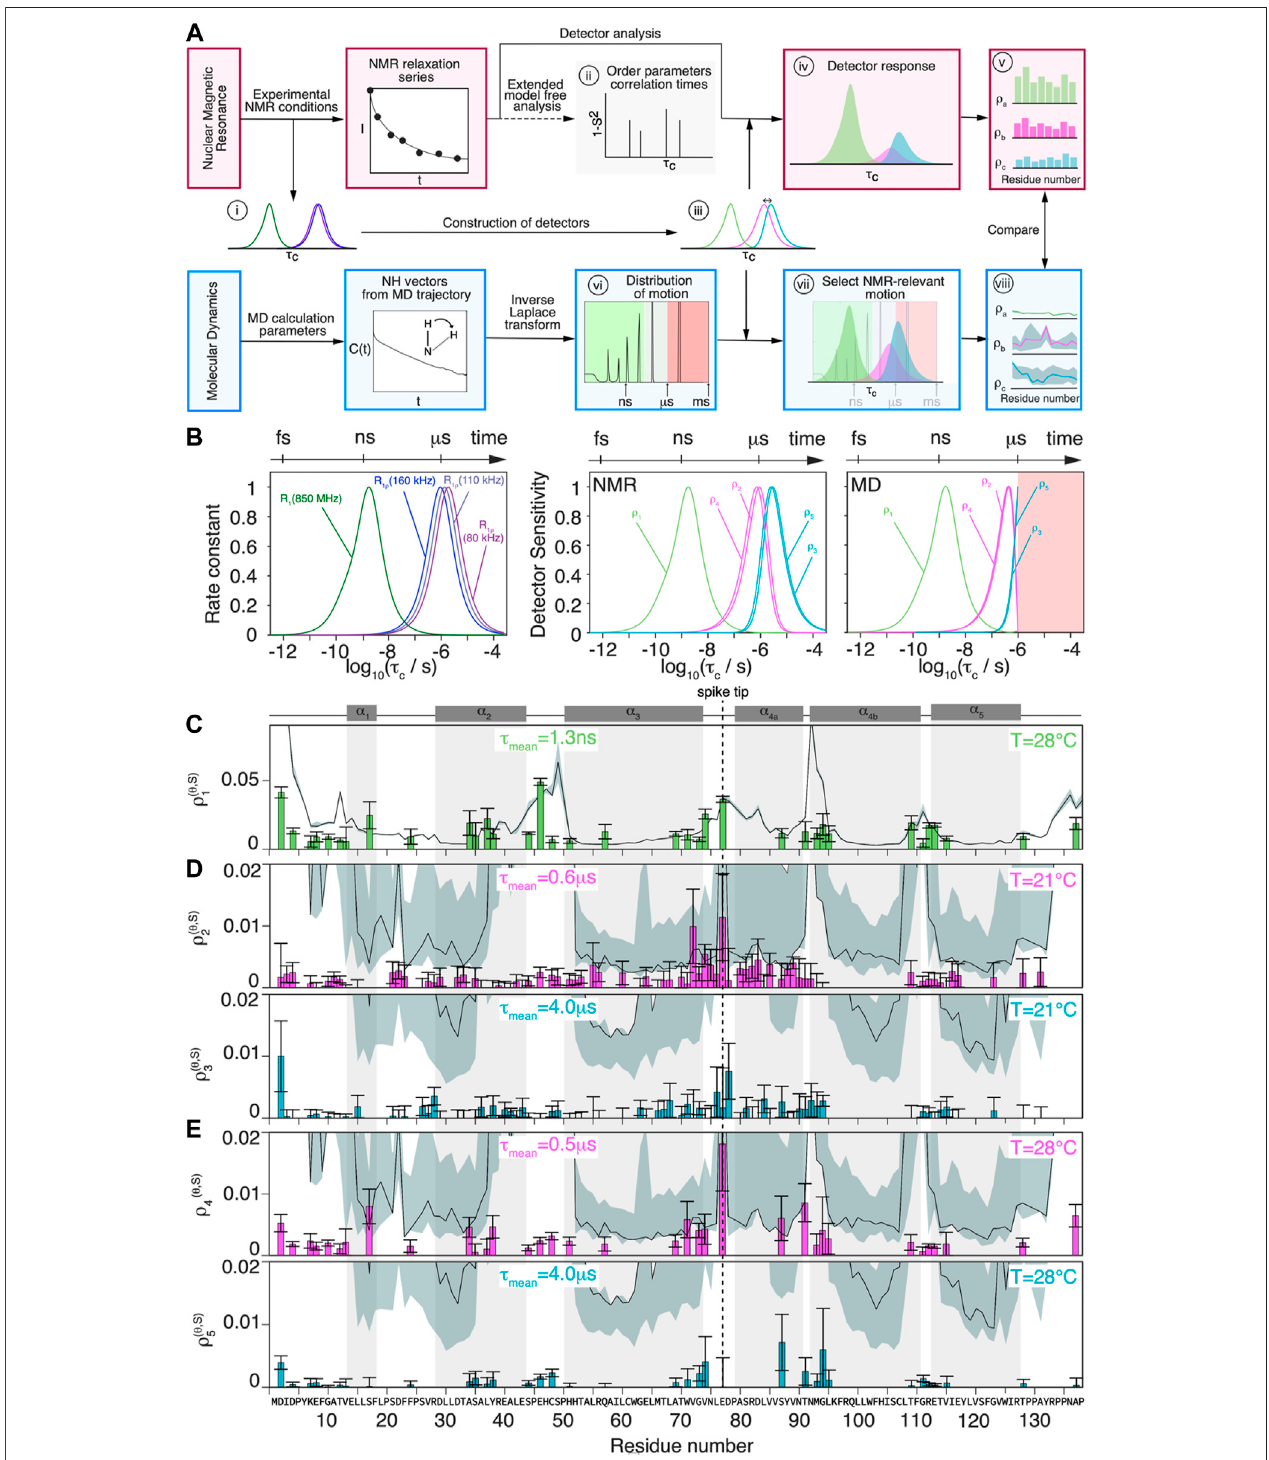
FIGURE4| Comparisonof MDsimulationandNMRdynamicsdetectorresponses. (A) Schematic fl owchartofthemethodusedtoobtaindetectorresponsesfrom theNMRdata(orangeboxes)andMD simulationtrajectory(blueboxes). (B) NormalizedanalyticalR 1 ( 15 N,86 MHz)andR 1 ρ ( 15 N, ] r (cid:1) 160/110/80 kHz, ] 1 (cid:1) 13 kHz)rate constants as function of the correlation time (left) and detector sensitivities constructed from linear combination of analytical rate constant functions depicted beside, where ρ 2 and ρ 3 correspondstothelinear combinationofR 1 ρ ( 15 N, ] r (cid:1) 110/80 kHz, ] 1 (cid:1) 13 kHz)and ρ 1 , ρ 4 and ρ 5 toalinearcombination ofR 1 ρ ( 15 N, ] r (cid:1) 160/ 80 kHz, ] 1 (cid:1) 13 kHz) and R 1 ( 15 N, 86 MHz). Optimization of detector sensitivities for analysis of the MD have been restricted to timescales up to 1 μ s . The axis on top